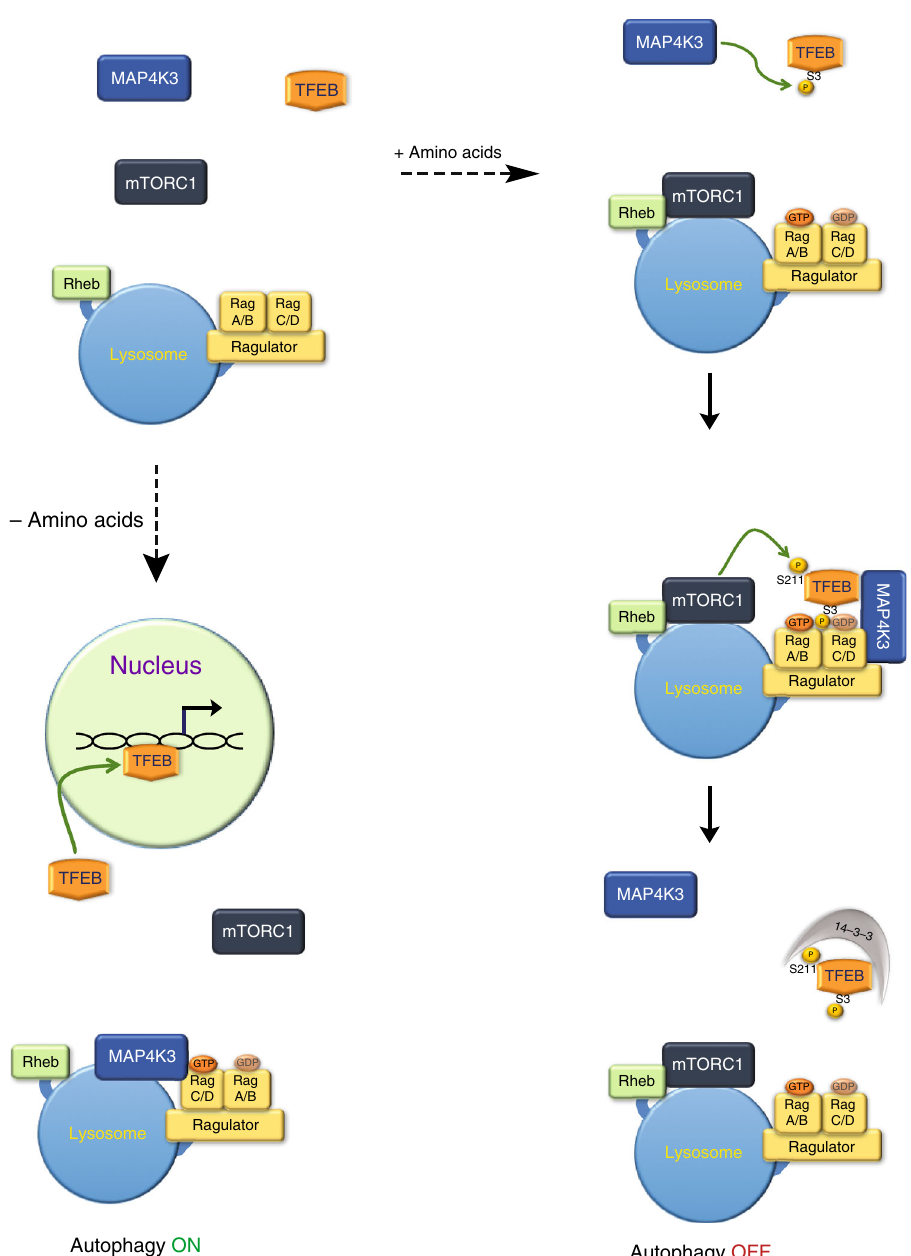
Fig. 9 Model for MAP4K3 regulation of TFEB activation-dependent autophagy. Right: when amino acids are abundant, MAP4K3 phosphorylates TFEB on serine 3 in the cytosol. TFEB serine 3 phosphorylation enables the Rag GTPases to recruit TFEB, which may still be in complex with MAP4K3, to the surface of the lysosome via the interaction of Rag GTPases with the Ragulator complex. Recruitment of TFEB to the lysosomal surface facilitates mTORC1 interaction with TFEB and mTORC1 phosphorylation of TFEB on serine 211. Upon serine 211 phosphorylation, TFEB is released from the lysosome to the cytosol, where 14-3-3 binds to TFEB and retains inactive TFEB sequestered in the cytosol. Left: when amino acids are scarce, MAP4K3 localizes to the lysosome and TFEB is thus no longer phosphorylated, permitting TFEB to translocate into the nucleus and activate the expression of genes that promote autophagy-lysosome pathway